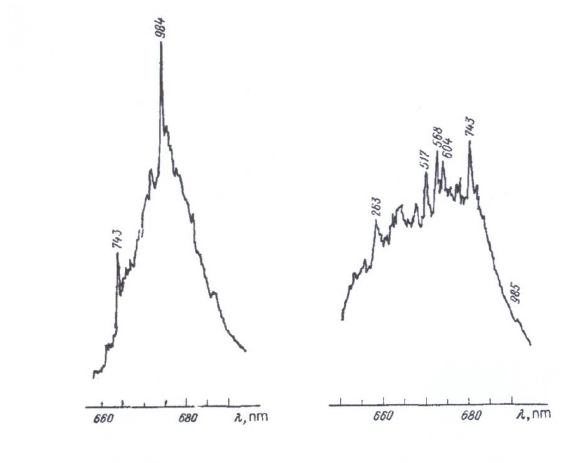
Figure 7. Fluorescence spectra of chlorophyll-a in toluene at 4.2 K. (Avarmaa and Rebane 1988).